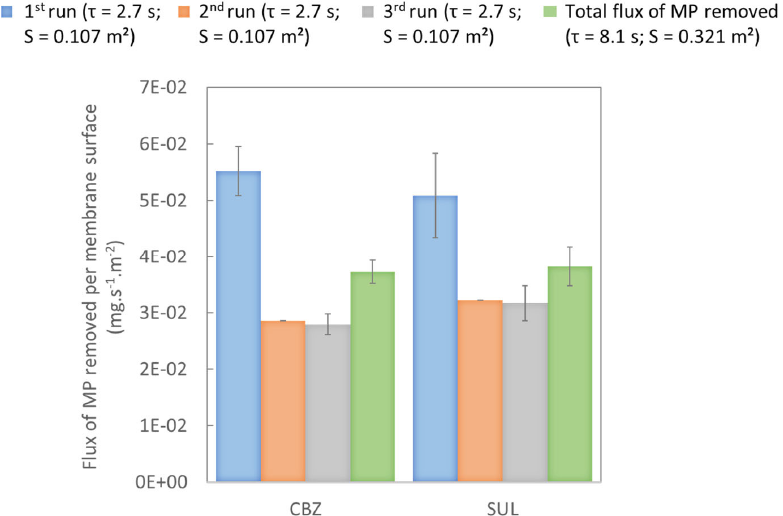
Figure 9. Flux of MPs removed per membrane surface during each run and total flux removed after 3 runs (mg.s − 1 .m − 2 ) in experiments with recirculating water with an ozone concentration at the gas ‐ phase inlet of 15 g.Nm − 3 , a liquid flow ‐ rate of 47.8 L.h − 1 and a gas flow ‐ rate of 8 L.h − 1 at neutral pH. CBZ and SUL flux removals were similar in each run. As CBZ is almost as reactive with molecular ozone as SUL (3.0 × 10 5 M − 1 .s − 1 and 4.2 × 10 5 M − 1 .s − 1 , respectively), as shown